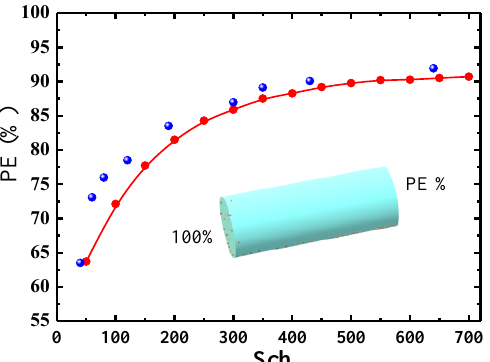
Figure 10. Penetration efficiency as a function of Sch (Re = 10,500, L/D = 208). ●: numerical results (cylindrical particle, λ = 1) and ●: experimental result (spherical particle) [27].